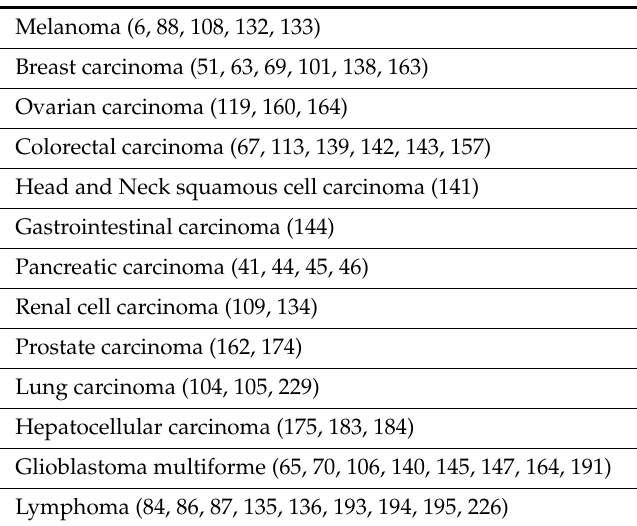
Table 5. Types of cancer with reported sensitivity to NDV